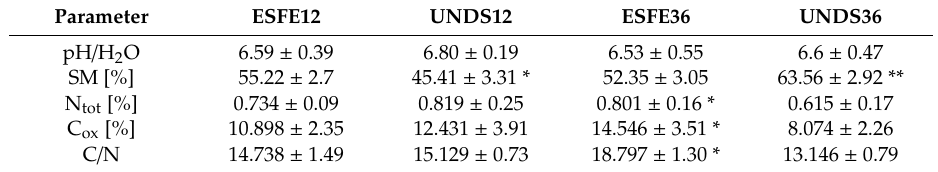
Table 2. Values of soil properties associated with early-successional forest ecosystem (ESFE) and windstorm undisturbed areas (UNDS) 12 and 36 months after event. Each data is an average of the individual plots and sampling date (mean ± S.D).